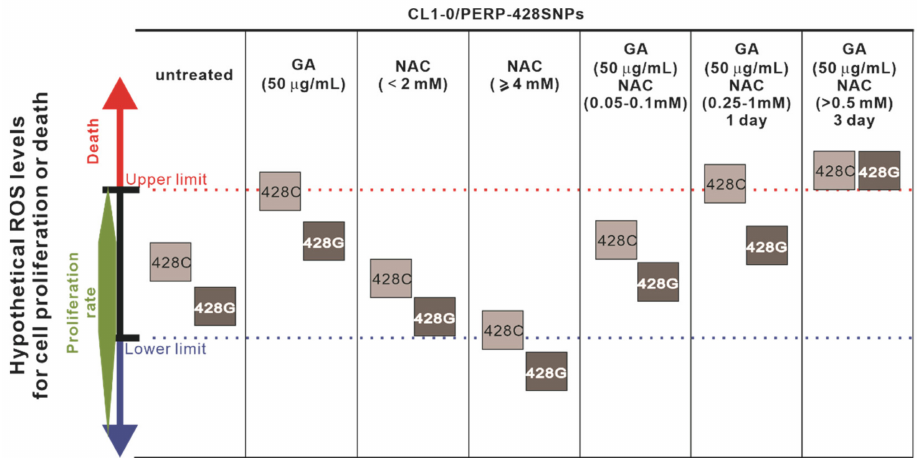
Figure 7. A diagram showing hypothetical ROS levels for cell proliferation or death after GA and/or NAC treatment. CL1-0 cells expressing PERP-428C or PERP-428G have different antioxidant capacities; therefore, they have different intracellular ROS levels (the first column). GA treatment increased ROS levels in PERP-428C cells to the upper limit of cell survival and induction of cell death (the 2nd column). NAC concentrations lower than 2 mM had no effect on cell proliferation, but NAC concentrations higher than 4 mM inhibited the proliferation of cells expressing PERP-428G more significantly than cells expressing PERP-428C (the 3rd and 4th columns). This effect may have been due to the antioxidant activity of NAC, which reduces the ROS levels of cells expressing PERP-428G to the lower limit of optimal cell proliferation. When the cells were cotreated with GA and NAC (0.05–0.10 mM), GA-induced cell death was eliminated in cells expressing PERP-428C , indicating that NAC acts as an antioxidant to reduce GA-induced ROS (the 5th column). However, in cells expressing PERP-428C , NAC concentrations higher than 0.25 mM enhanced GA-induced cell death (the 6th column). This phenomenon may be due to the high level of NAC in the H 2 O 2 environment induced by GA becoming a significant pro-oxidant. Although GA cotreatment with NAC concentrations higher than 0.25 mM did not induce the death of PERP-428G -expressing cells in one day, most cells died on the third day after treatment (the 7th